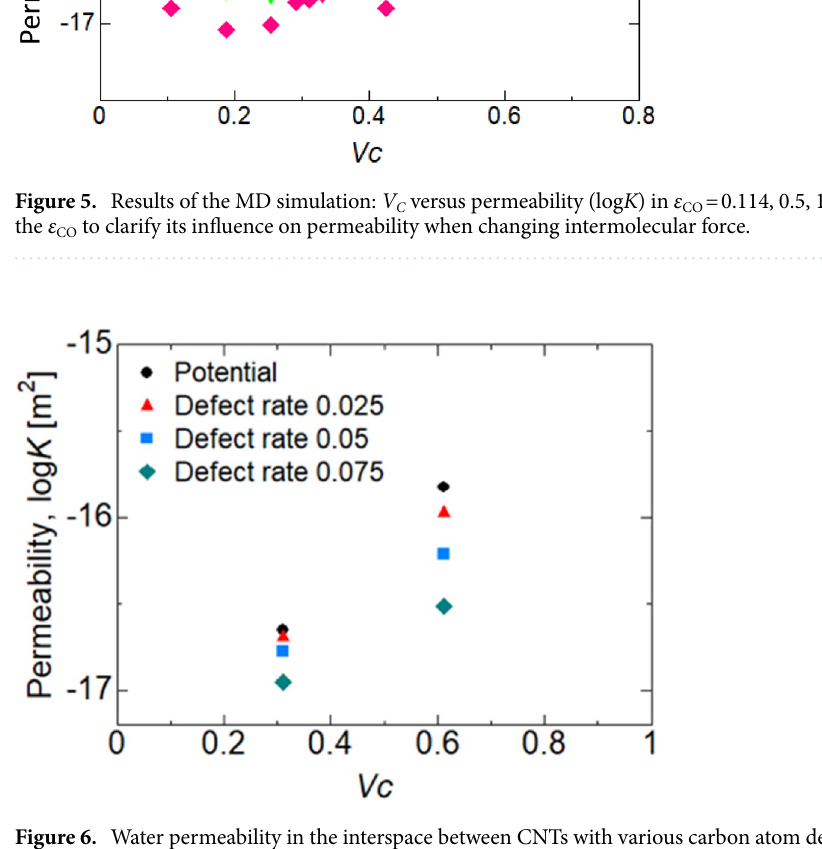
Figure 6. Water permeability in the interspace between CNTs with various carbon atom defect